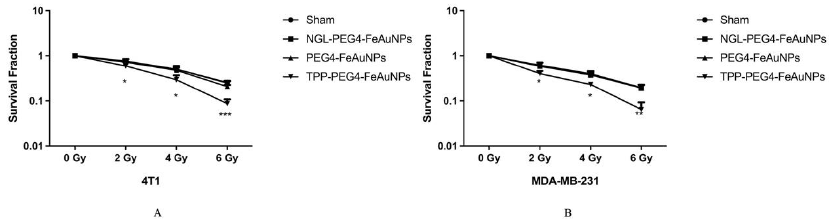
Figure 4. Clonogenic cell survival of 4T1 ( A ) and MDA-MB-231 ( B ) TNBC cells after treatment with NGL-PEG4-FeAuNPs, PEG4-FeAuNPs and TPP-PEG4-FeAuNPs (each 2.5 µ g/mL for 24 h) or a sham treatment followed by an irradiation with 0, 2, 4 and 6 Gy. Significant differences were observed between the sham and TPP-PEG4-FeAuNP-treated cells. Significance: * p ≤ 0.05, ** p ≤ 0.01, *** p ≤ 0.001; results represent the mean values ± SD of 3 independent